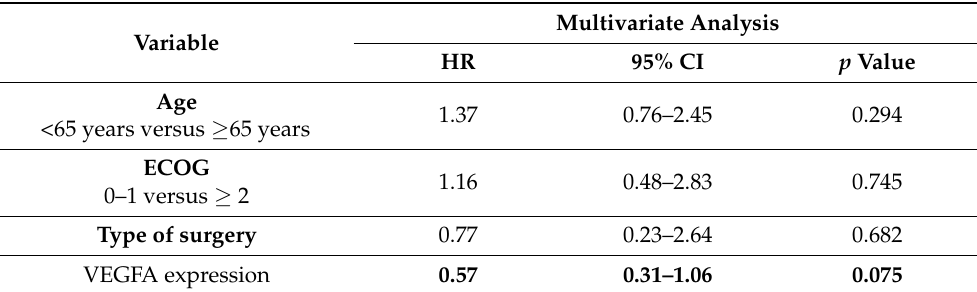
Table 8. Multivariate analysis of independent predictors of progression-free survival after beva- cizumab treatment (PFS-2) of GB